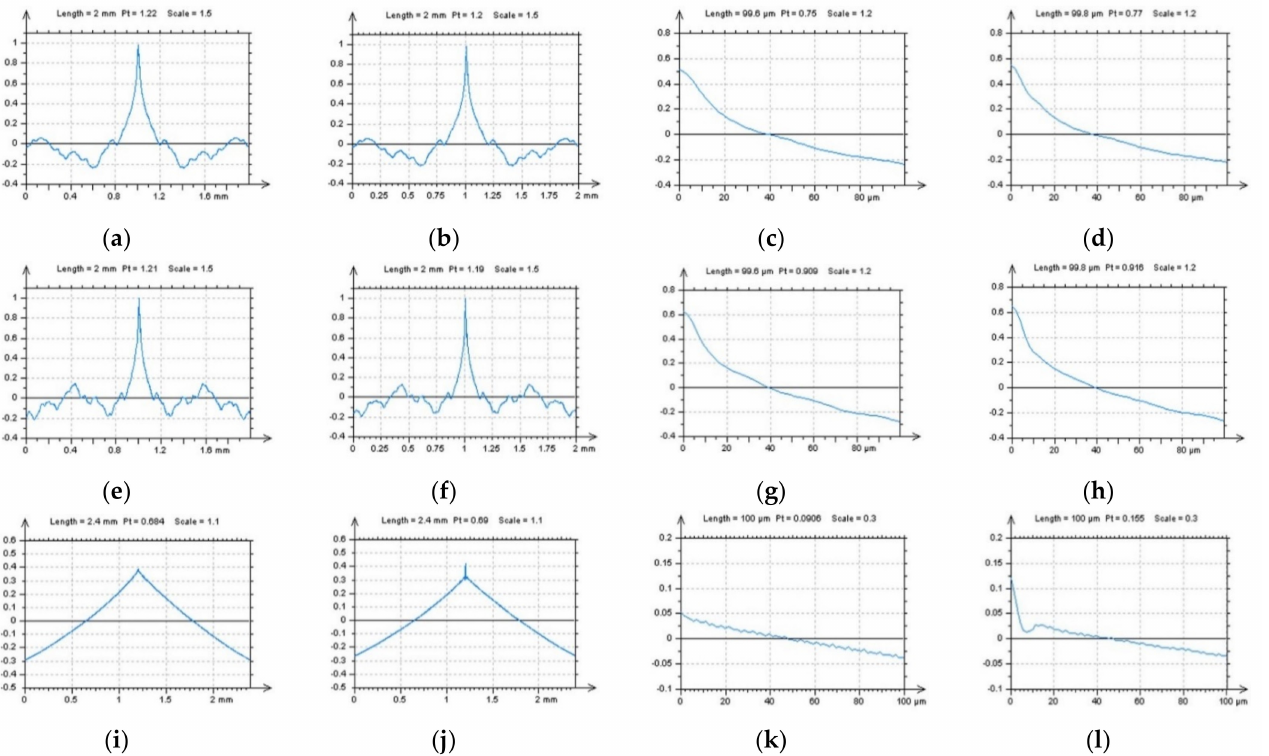
Figure 8. Profiles (2D) of ACF extracted from a 3D (areal) of ACF presented in Figure 7, from raw mea- sured data ( a , c , e , g , i , k ) and data with high-frequency noise ( b , d , f , h , j , l ), containing profiles extracted with horizontal p1 ( a – d ), vertical p2 ( e – h ) and treatment-trace p3 ( i – l ) performance (description of the direction of the extraction process was included in Figure